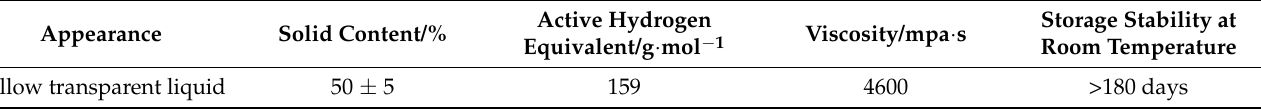
Table 7. Coating properties of E44 cured with different curing agents.